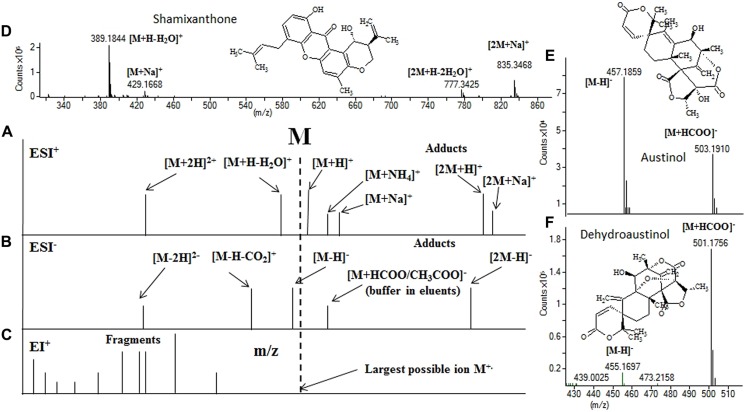
Position of ions relative to the monoisotopic mass, of ESI+ (A), ESI- (B) and EI+ (C) along with adduct ions, and 3 example ESI spectra. In shamixanthone (D) the [M+H]+ ion is absent but the molecular mass can easily be assigned using the Δ40 (39.9925) between the [M+Na]+ and the [M+H-H2O]+. In (E,F) the big difference of formate adduct intensity on the austinols (same run, elutes 0.4 min in-between) is illustrated. For instrument settings see Kildgaard et al. (2014).